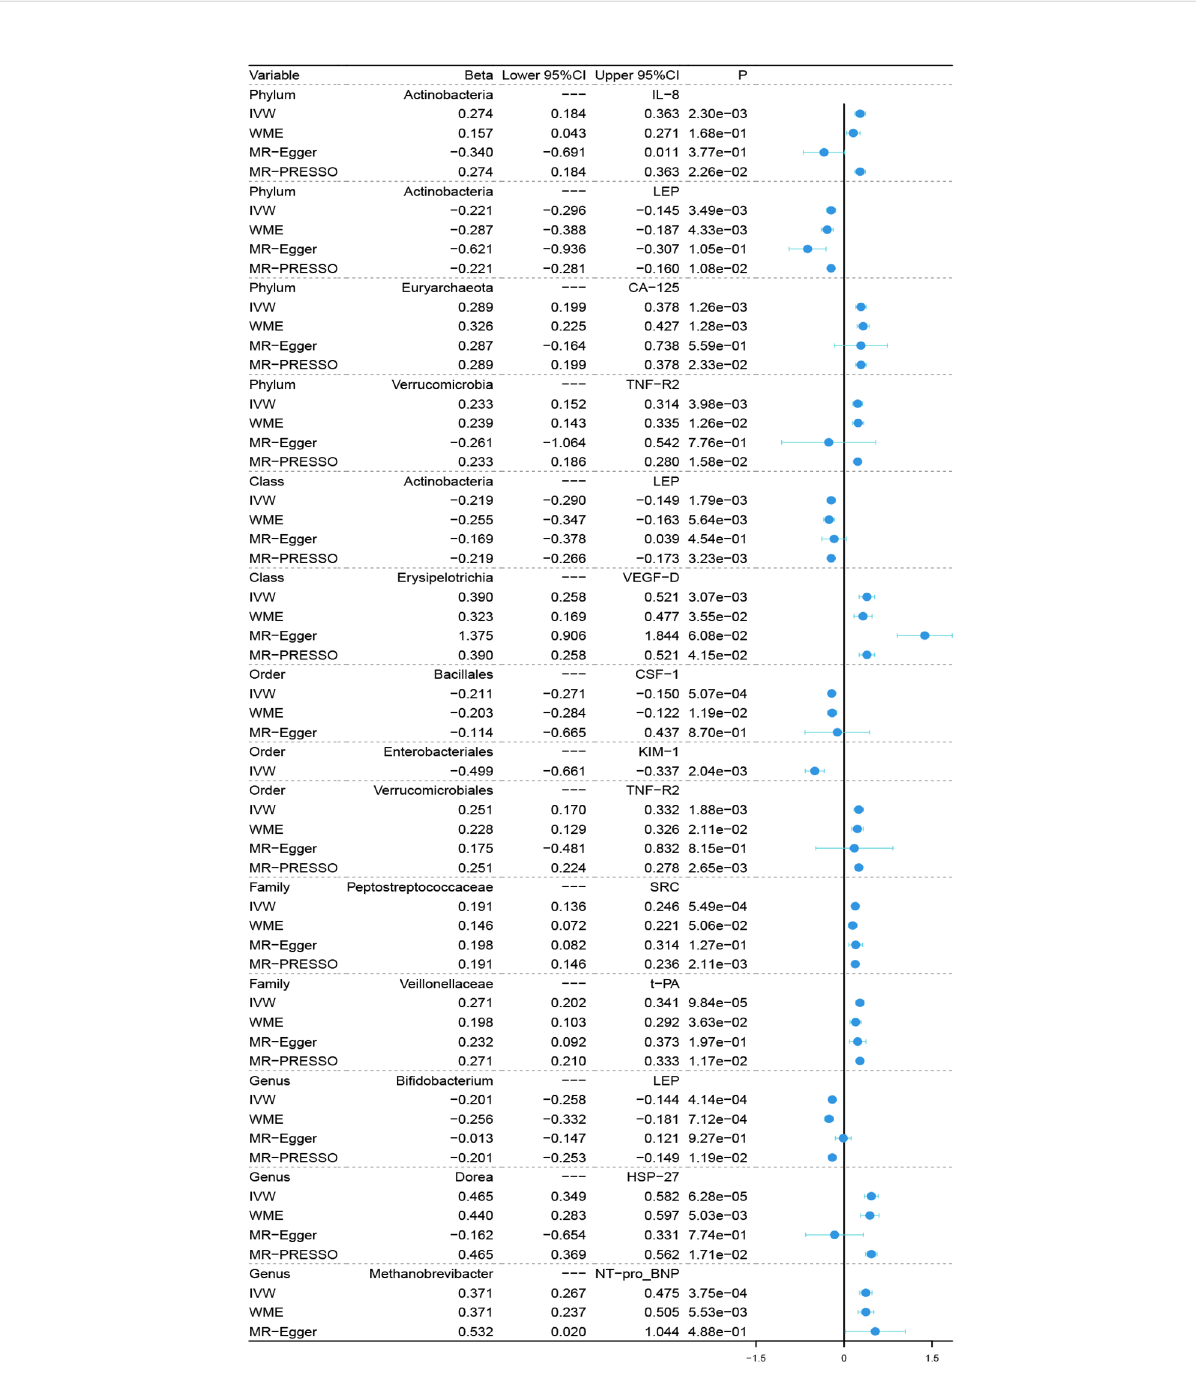
FIGURE 1 Forest plot of causal relationships estimated for 13 microbiota and 11 cardiovascular proteins using four MR methods. IVW, inverse variance weighted; WME, weighted median estimator; MR-Egger, MR-Egger regression; MR-PRESSO, MR-PRESSO test; MR, Mendelian